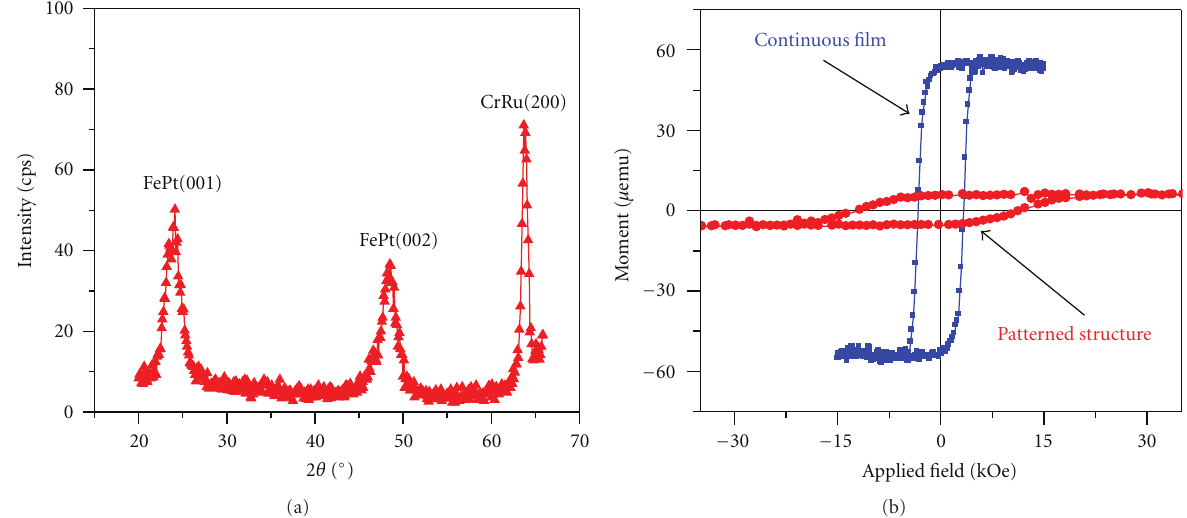
Figure 4: (a) XRD diagram of continuous FePt film and (b) M-H loops of continuous film and patterned FePt structure as marked. The size for the magnetic measurement of both samples was 0.25 cm 2